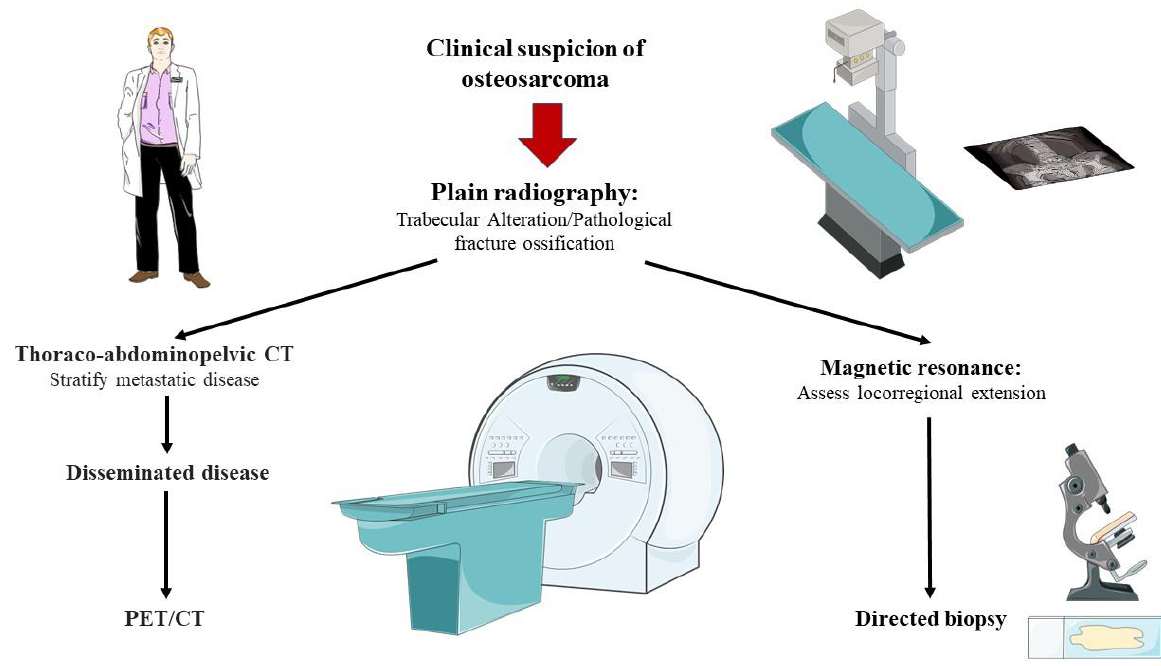
Figure 2. An overview of the clinical diagnosis of osteosarcoma.